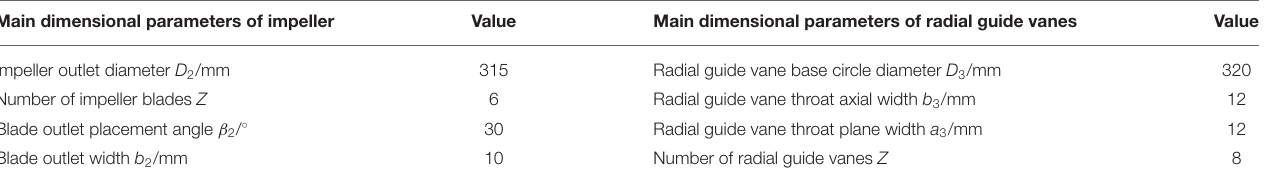
TABLE 1 | Dimensional parameters of impeller and radial guide